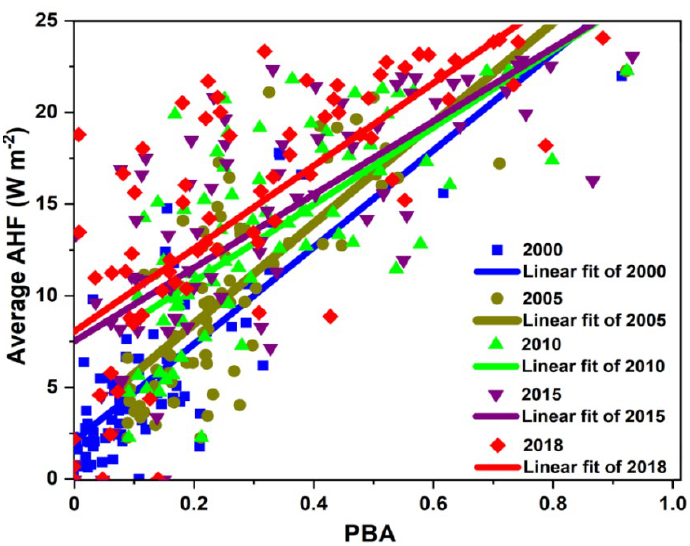
Figure 6. Scatter plots and linear plots of the relationship between the average AHF and the PBA in a 5-km radius buffer zone around the meteorological stations.